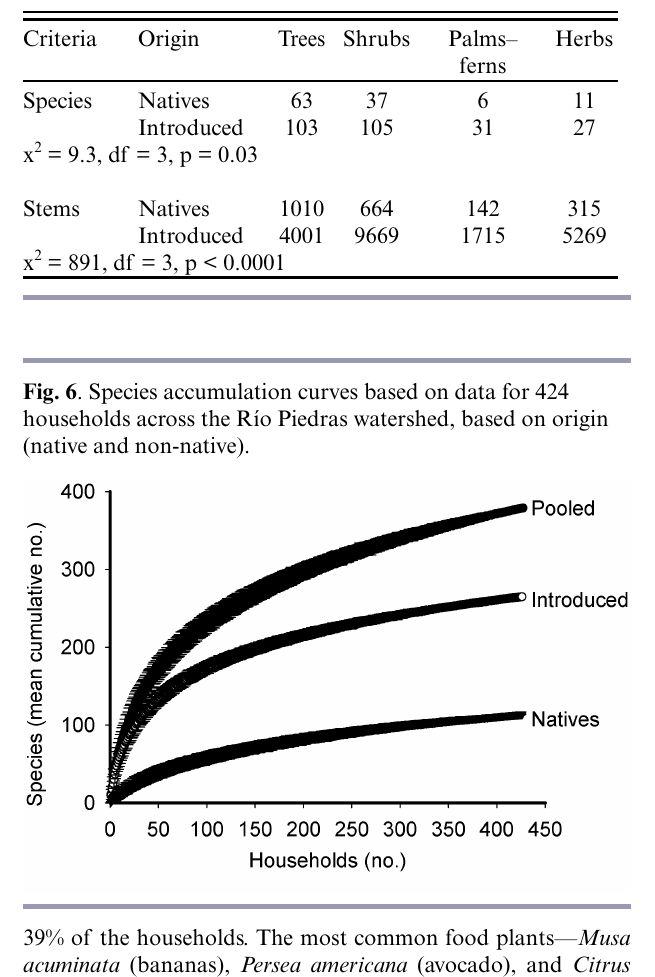
Fig. 7 . Species accumulation curves based on data for 424 households across the Río Piedras watershed, based on utilitarian